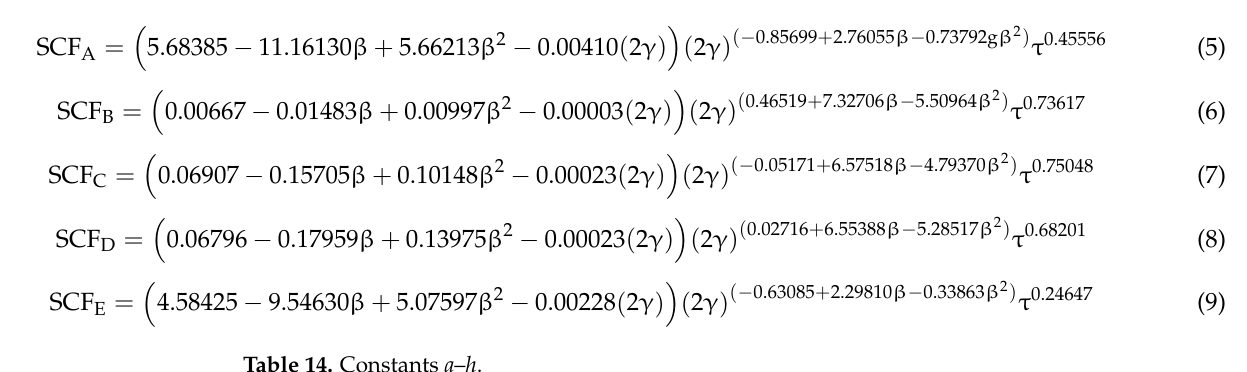
Table 14. Constants a – h .